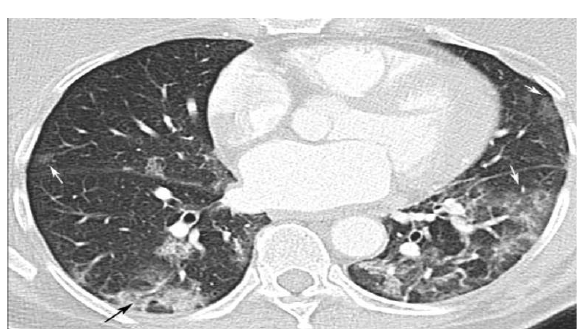
Figure 2.2: Presence of GGO’s in the infected lung (right) as opposed to a healthy lung (left) [3]